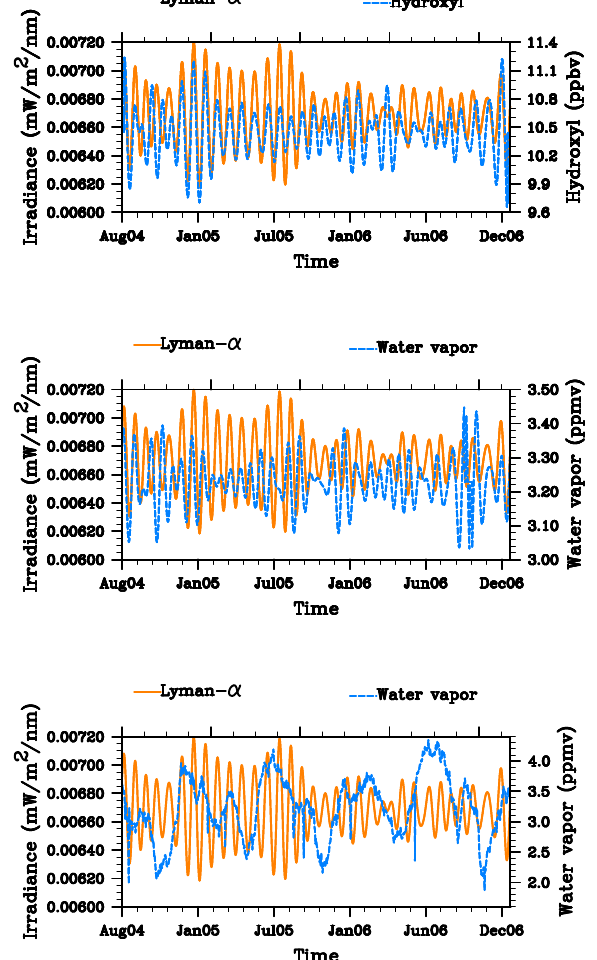
Fig. 2. Comparison of the tropical mean daytime averaged and 20- 35 day filtered MLS OH at ∼ 78km altitude (upper panel) and fil- tered (central panel) and unfiltered (lower panel) H 2 O at ∼ 80km altitude with SOLSTICE Ly- α line irradiance. The comparison is performed for the period from August 2004 to December